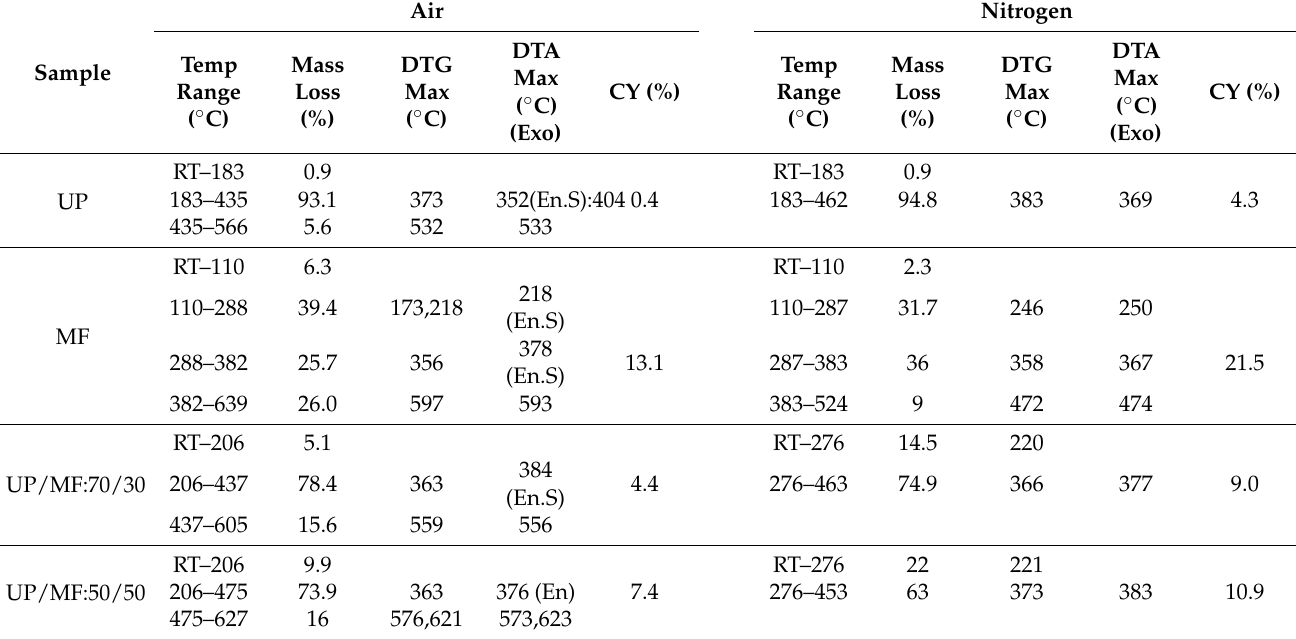
Table 4. TGA, DTG, and DTA analyses of cured UP and MF resins, and their blends in air and